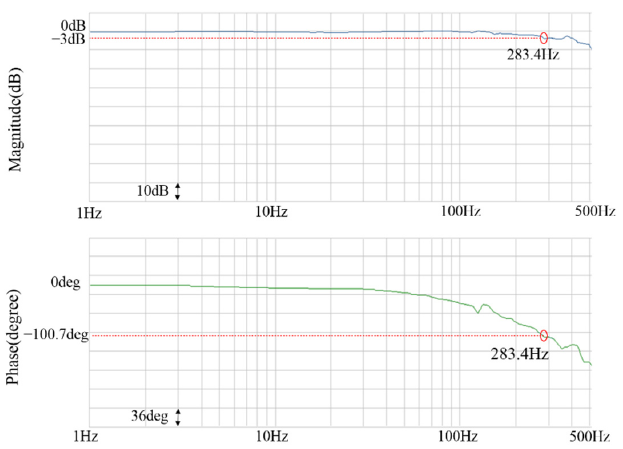
Figure 14. Bode plots of q -axis current control loop using PI controller at 1000 rpm with 4.75 Nm.